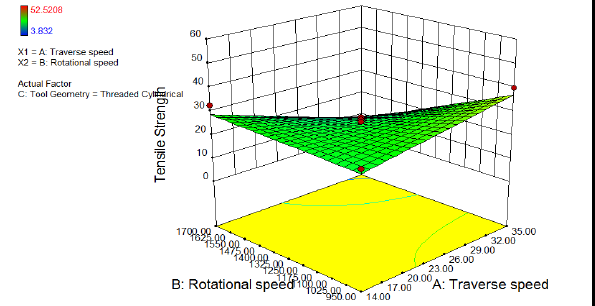
Fig. 13: 3D-Graph Interaction of Traverse vs Rotational Speed for Tensile Strength with a Simple Cylindrical Conical Tool different aspect of this graph is that maximum